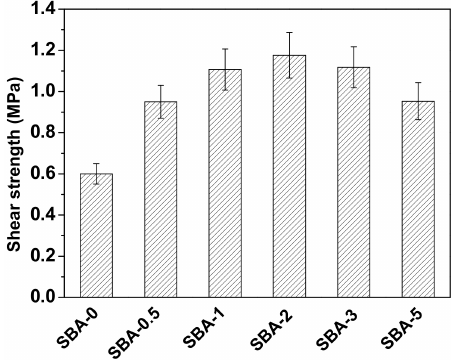
Figure 5. Shear strength of plywood bonded with the SBAs (Shear strength of each sample are significantly different ( p ≤ 0.05)).